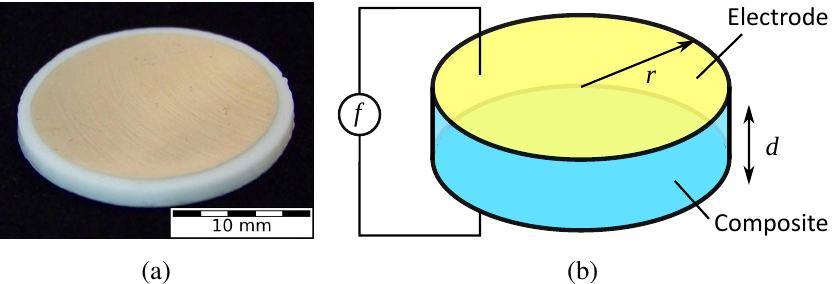
Figure 5. ( a ) A test specimen for dielectric analysis, with sputtered gold electrode on top. ( b ) Schematic of the dielectric characterization method, using the parallel plate capacitor